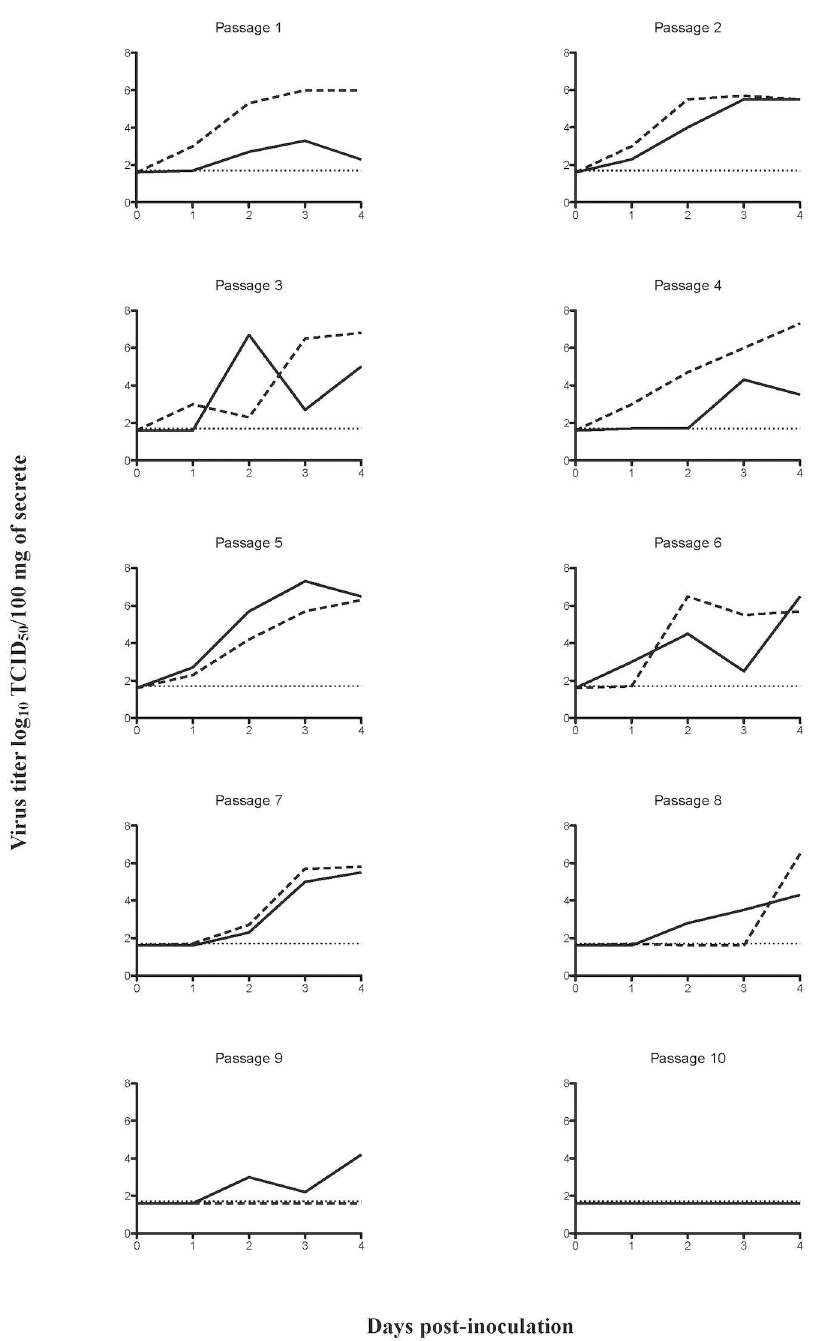
Fig 1. Nasal virus excretion of A/quail/Hong Kong/G1/1997 influenza virus during ten blind serial pig passages. Two pigs (solid line and dashedline) were involvedin each passage,each line representsthe individual virus titers in nose swabs. The detection limit of the test is indicatedwith a dotted line at 1.7 log 10 TCID 50 /100 mg of